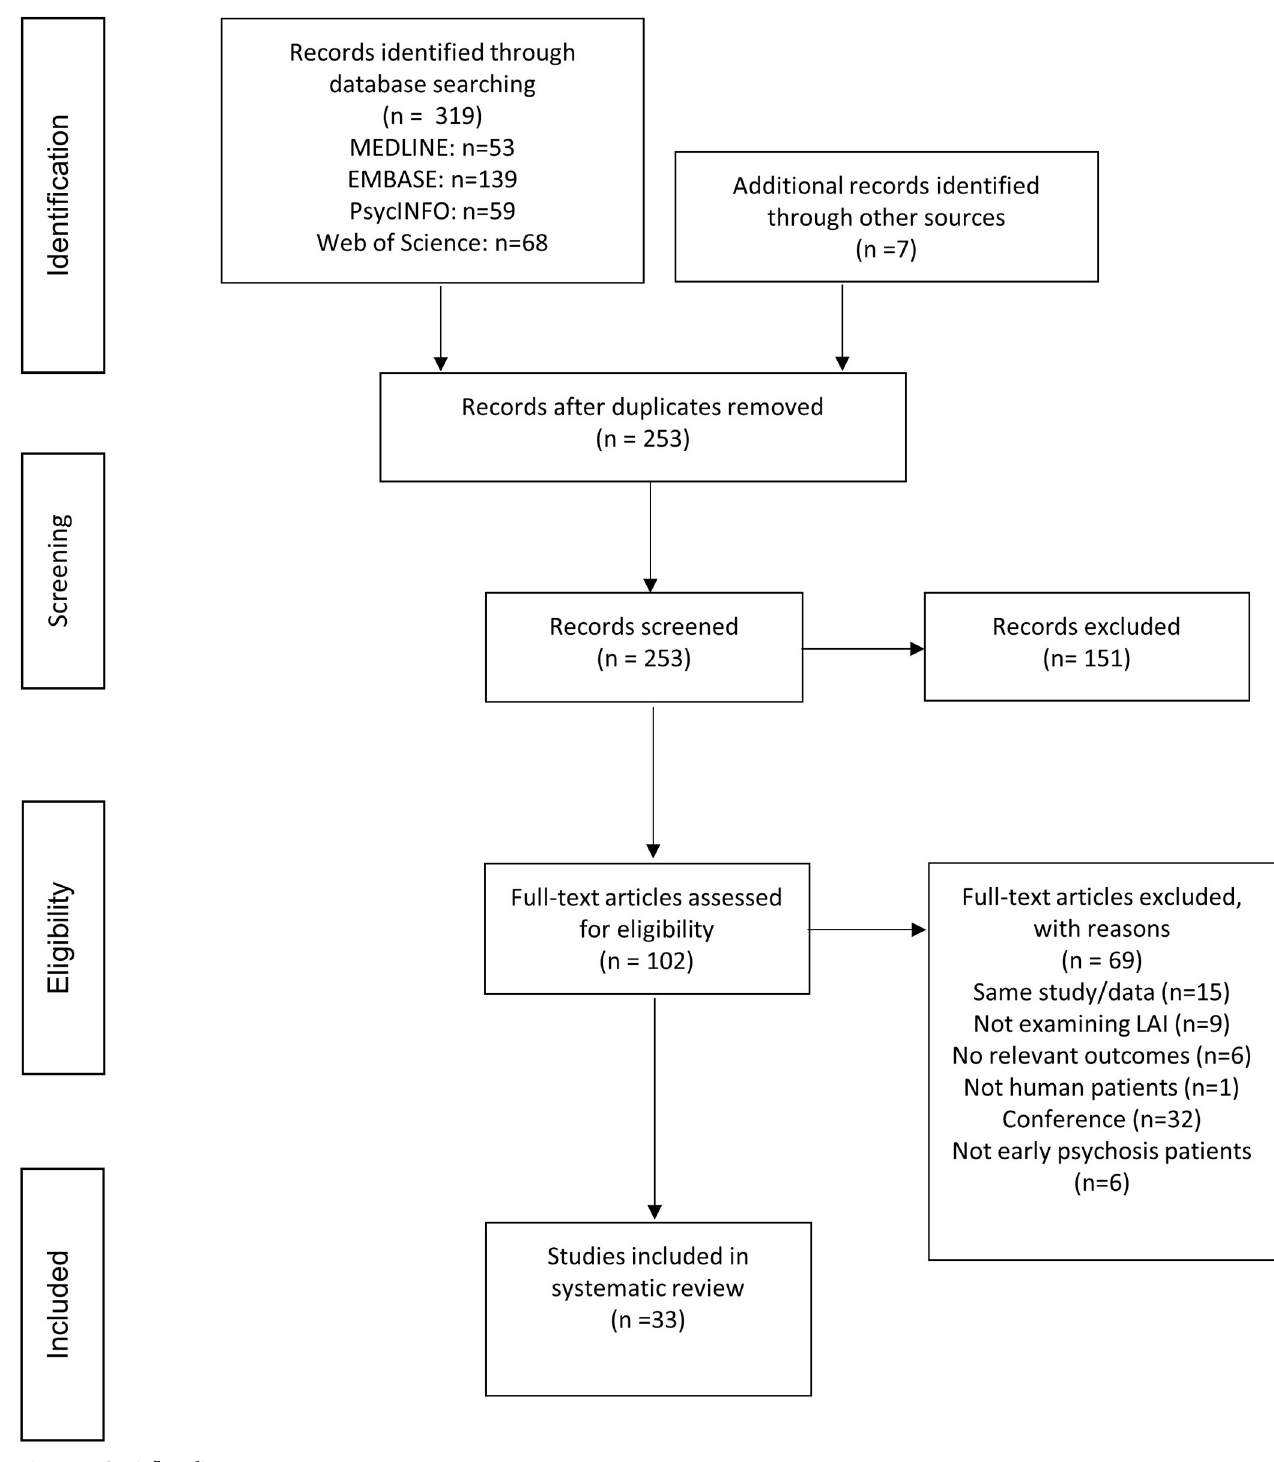
Fig 1. PRISMA flow diagram.